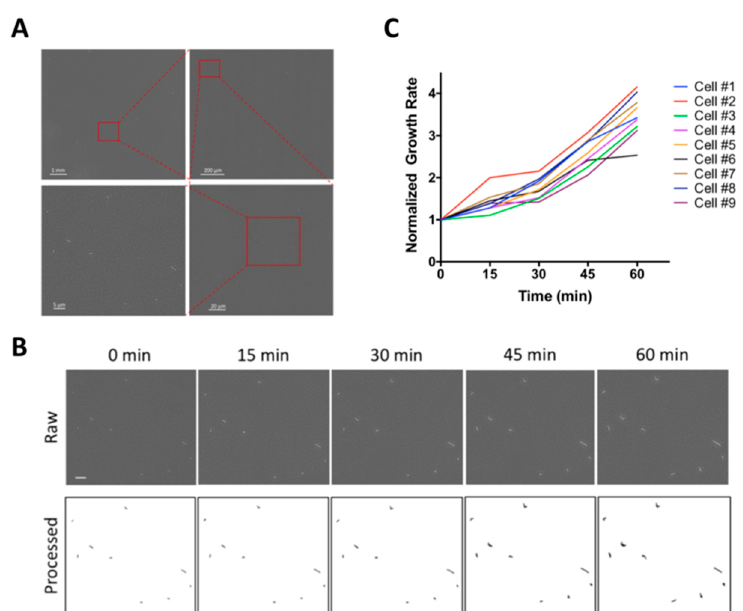
Figure 1. ( A ) A representative composite image captured by the reported platform. Zooming in the image allows the visualization of single bacterial cells. ( B ) Time-lapse images of one representative area selected from the composite image and corresponding post-processing binary images. Scale bar, 5 µm. ( C ) Single-cell growth rate of bacterial cells presented in ( B ).